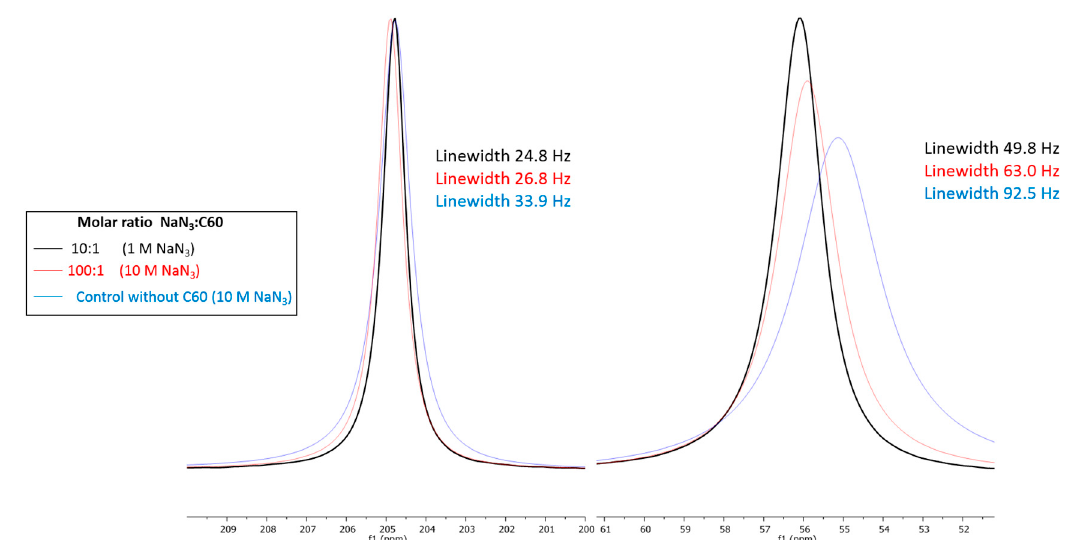
Figure 6. At a high molar ratio NaN 3 :C60 (>10:1), there are some subtle changes in the 14 N NMR chemical shift and line-width of both NaN3 peaks.